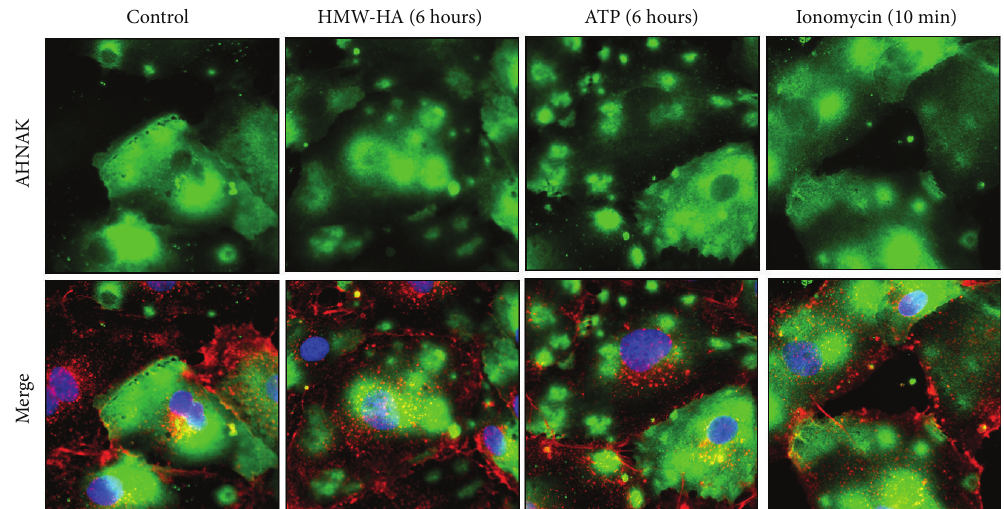
Figure 3: Analysis of HMW-HA-induced AHNAK redistribution in human EC. HPMVEC were grown to confluence on glass coverslips and treated with 100nM HMW-HA for 6 hours. 50 𝜇 M ATP (six hours) and 3 𝜇 M ionomycin (10 minutes) were used as controls due to their previously reported ability to stimulate enlargeosome exocytosis [21–24]. The samples were then fixed in 4% paraformaldehyde and subjected to immunocytochemical analysis using AHNAK antibodies (green). Plasma membranes were labeled with Alexa Fluor 594 wheat germ agglutinin (red) and nuclei were stained with Hoechst 33342 (blue). Control HPMVEC exhibited diffuse cytoplasmic AHNAK staining. When stimulated with HMW-HA, intracellular AHNAK redistributed to a “vesicular” pattern which is similar to treatment with ATP and